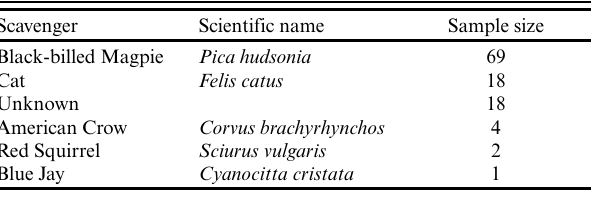
Table 3 . Type and sample size of scavengers reported during carcass removal trials.